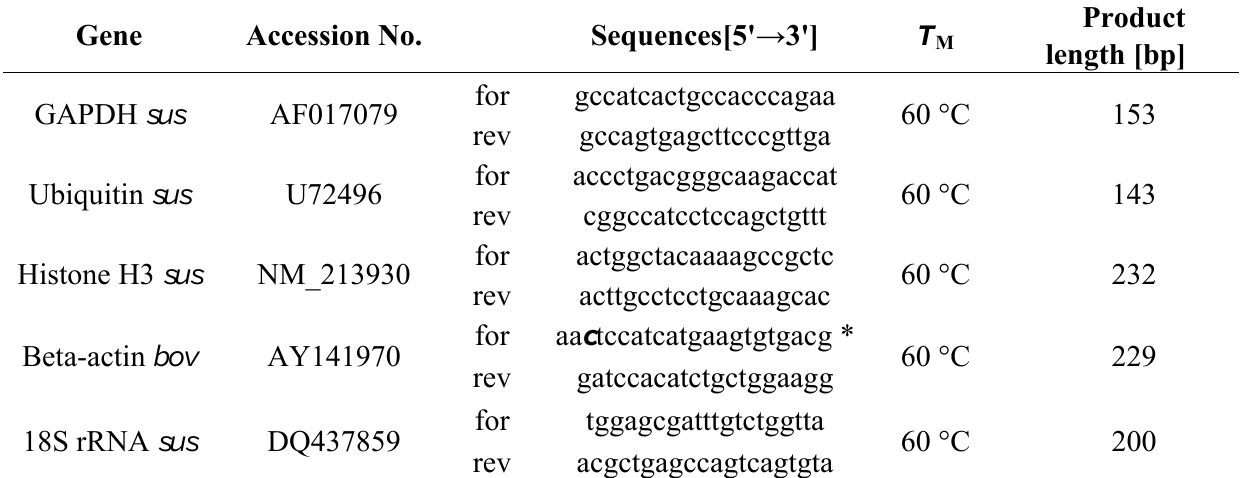
Table 3 . Details of primers used for each of the five evaluated